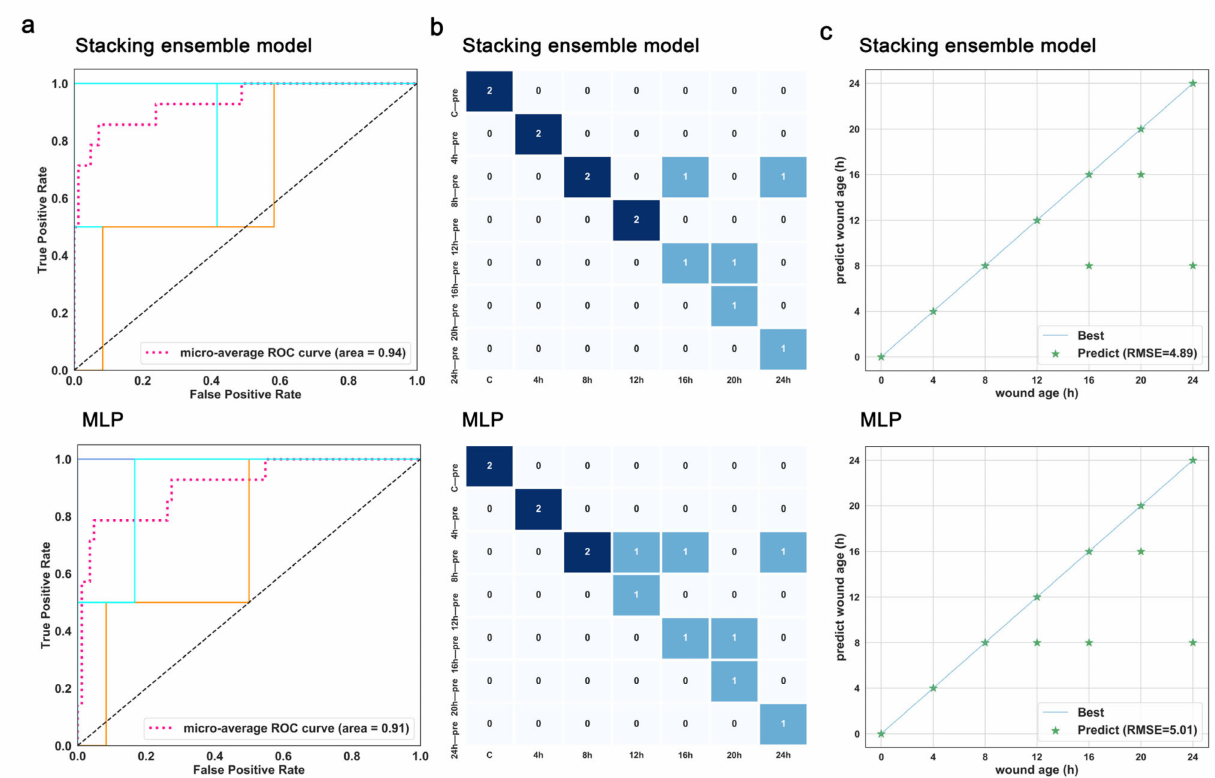
Figure 7. Comparison of the prediction performance between the stacking model of “RF + SVM + MLP” and MLP for wound age estimation in external validation. ( a ) AUROC, ( b ) confusion matrix, ( c ) RMSE of the stacking model (RF + SVM + MLP) and MLP. The pattern on the diagonal line indicates that the estimated value matches the actual value. The greater the error, the greater the distance between scatter and line. Abbreviations: RF: random forest; SVM: support vector machine; MLP: multilayer perceptron; GB: gradient boosting; SGD: stochastic gradient descent; AUROC: area under the receiver operating characteristic curve; RMSE: